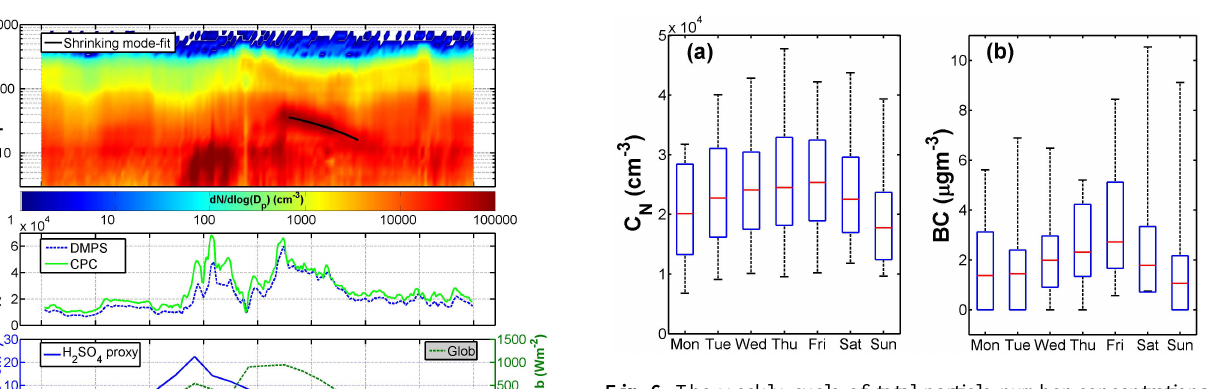
Fig. 6. The weekly cycle of total particle number concentrations and BC. Median values are in red, 75th and 25th percentiles in blue and 95th and 5th percentiles as black whiskers. (a) The weekly cycle of the total particle number concentration. Sundays had the lowest and Fridays the highest concentrations, 1.78 × 10 4 and 2.53 × 10 4 cm − 3 , respectively, at STP conditions. (b) Median BC mass concentrations show a similar pattern with the lowest me- dian value of 1.06µgm − 3 on Sundays, and the highest on Fridays 2.71µgm − 3